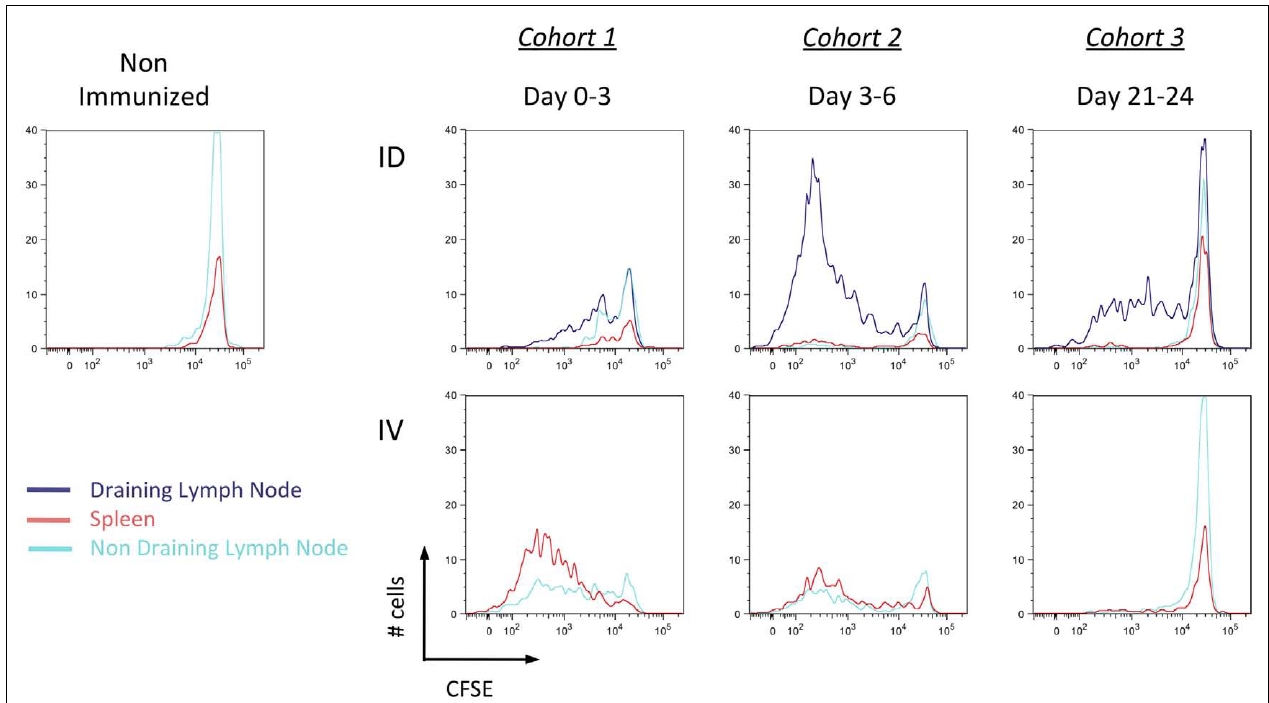
FIGURE 6 | Delayed but persistent antigen presentation in the local draining lymph node after intradermal immunization. Mice were immunized i.d. or i.v. with 5 × 10 5 K bm1 mOva splenocytes. On days 0, 3, or 21, 5 × 10 6 CD45.1 CFSE-labeled OT-I splenocytes were adoptively transferred